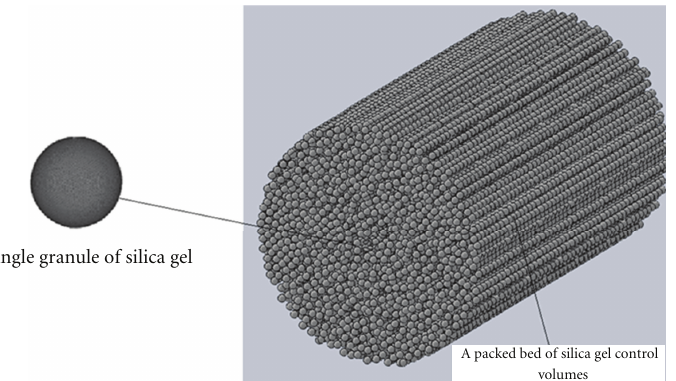
Figure 3: Thousands of granule pack the silica gel into a 3D adsorption bed.